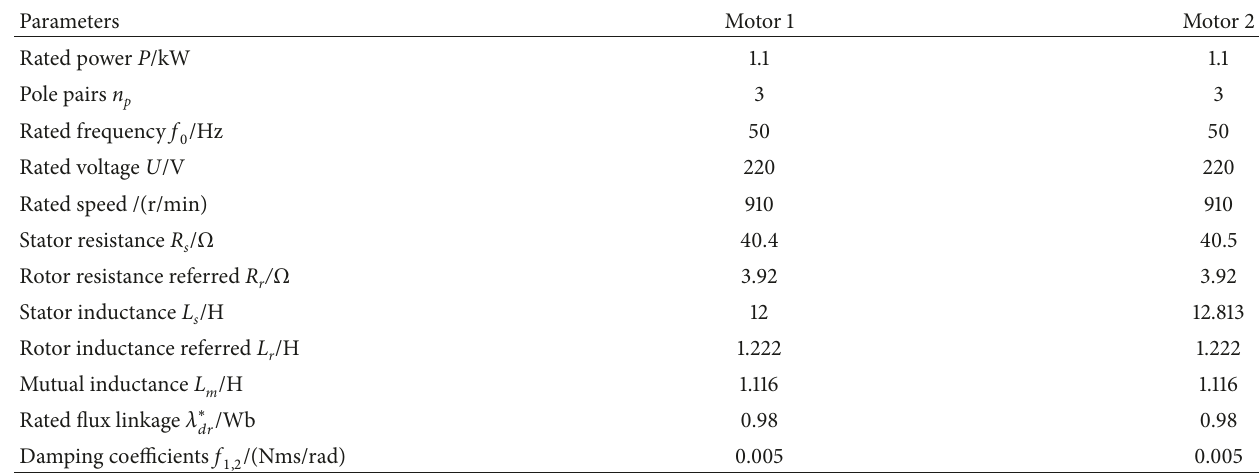
Table 1: Parameters of the two inductor motors.